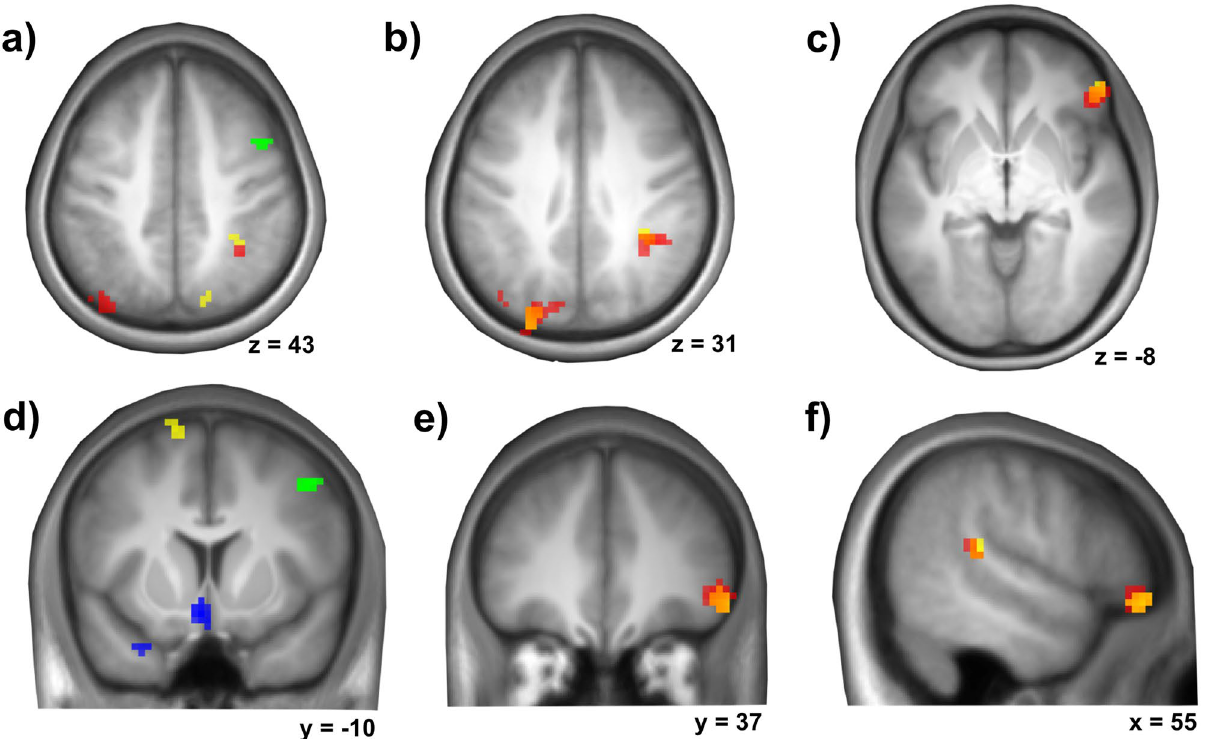
Figure 2. Multi-voxel pattern analyses: correlates of voice- and face-preferential responses. Areas of the RSFC patterns which significantly correlate with the individual responses to the preferred cues of FFA and TVA (red/ yellow: right/left TVA voice-preferential responses ( a–f ); orange: overlap of right/left TVA voice-preferentiality correlates ( b,c,e,f ); green/blue: right/left FFA face-preferentiality correlates ( a,d ). Underlying RSFC patterns of informative clusters not shown here. Results are shown at a voxel-wise threshold of p < 0.001 and whole brain FWE-corrected at cluster level with additional Bonferroni-correction for the number of tested regressors (4) leading to an effective cluster threshold of p < 0.0125.